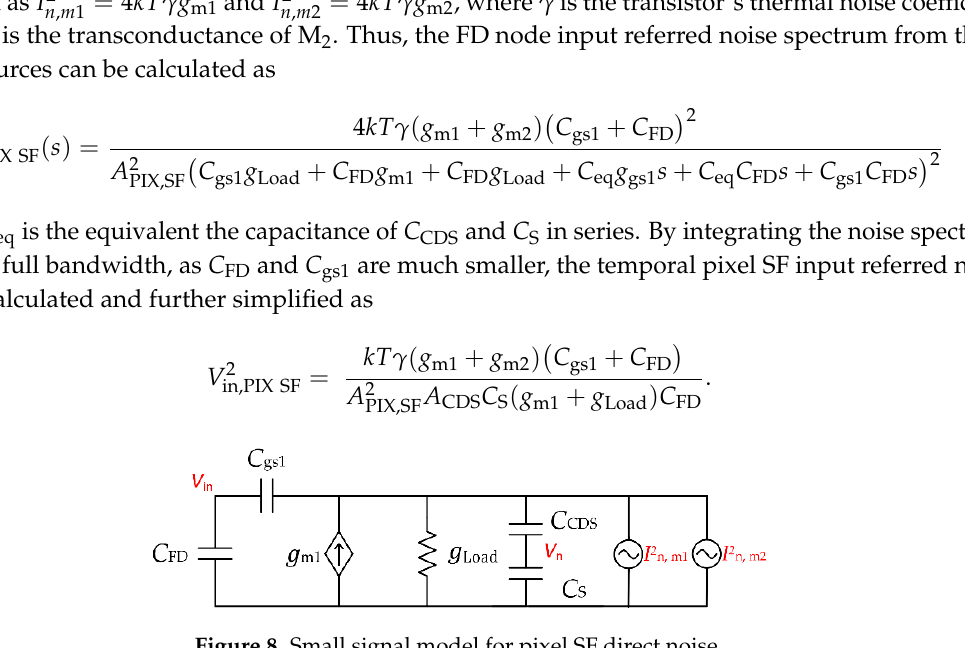
Figure 8. Small signal model for pixel SF direct noise.